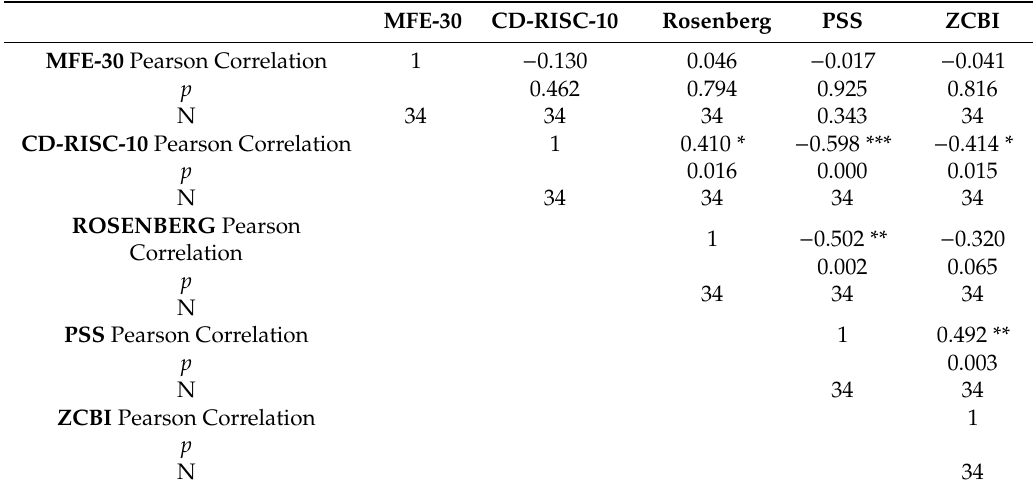
Table 3. Correlations for the measures obtained in the caregivers’ group